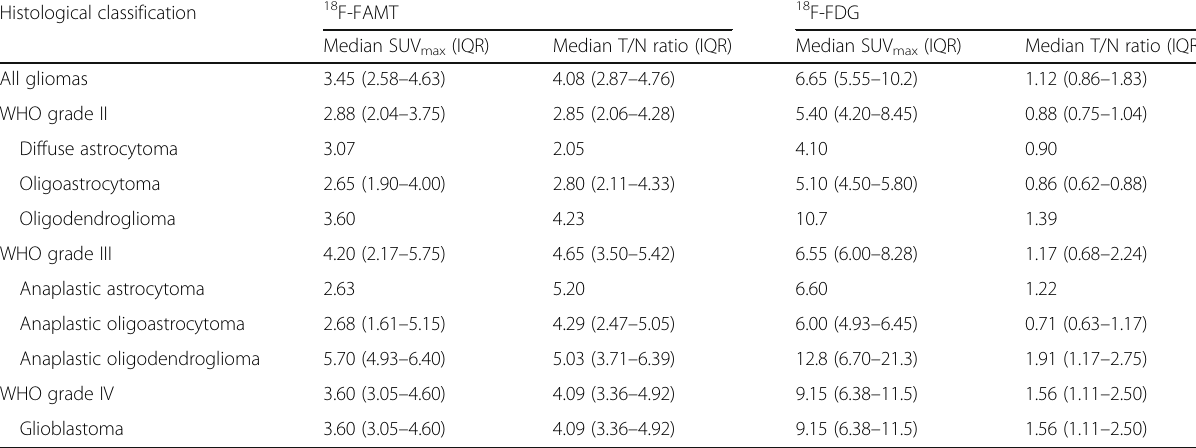
Table 2 18 F-FAMT and 18 F-FDG uptake in various tumor types Histological classification